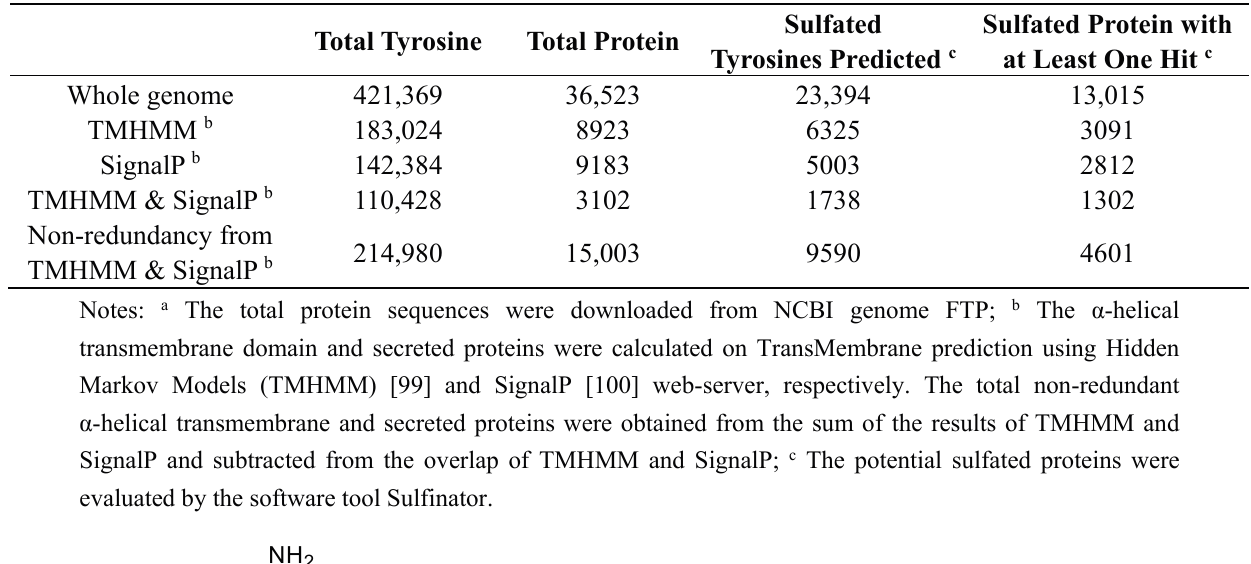
Table 3. Prediction of tyrosine sulfation in humans a .